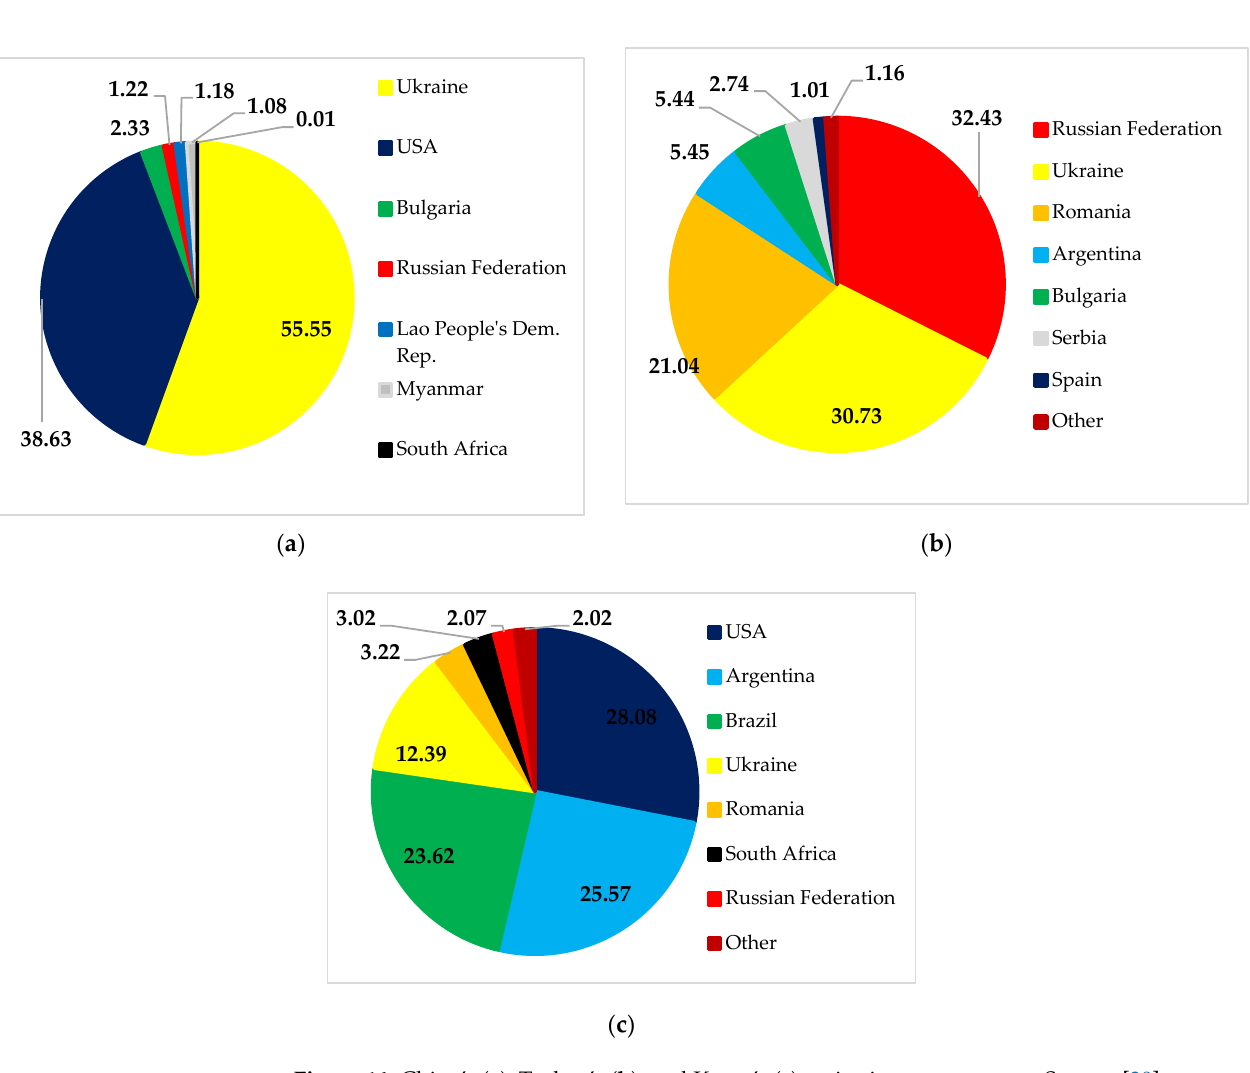
Table 4. Ukrainian wheat and maize exports value to the world (000 USD). Wheat Maize Month Mean Std. Deviation Mean Std. Deviation